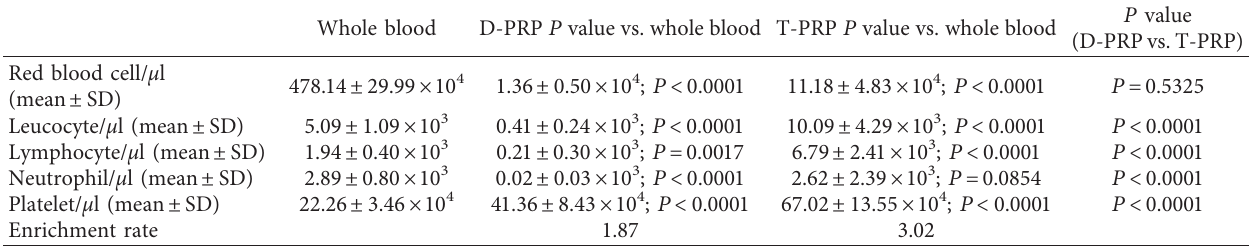
Table 1: Comparison of the number of blood cells (/ μ l).